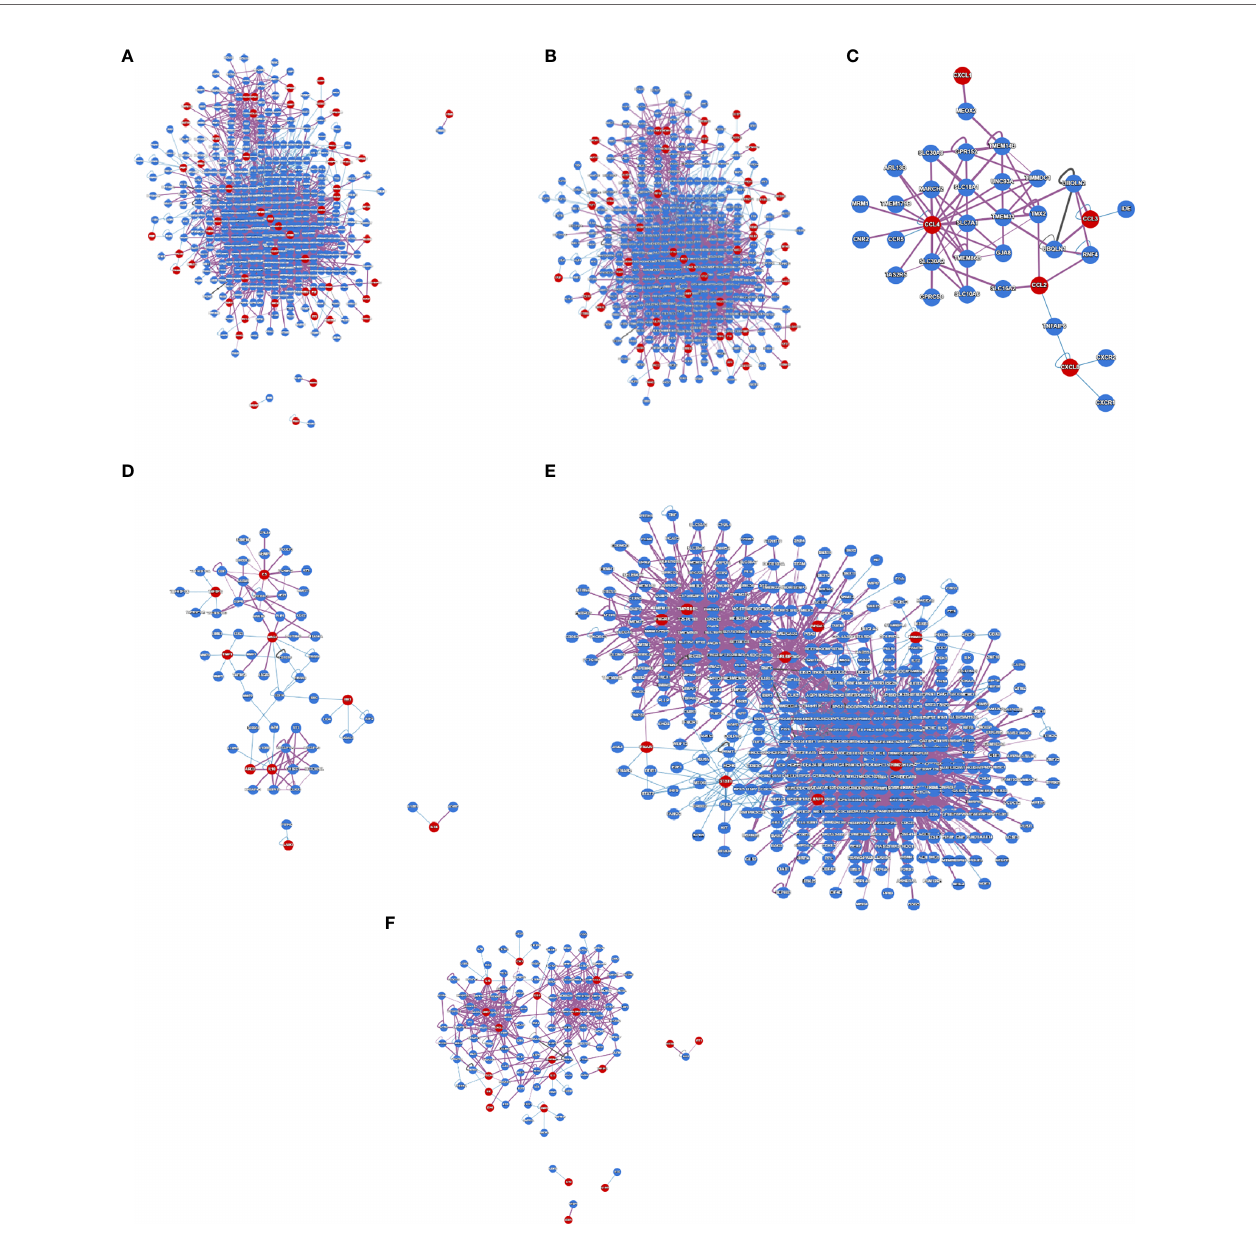
FIGURE 6 | The protein interactome map constructed using protein-coding DEGs from our study and other studies. (A) The protein interactome map with protein-coding genes from the 250 DEGs in our research. (B) The protein interactome map of the central cluster from our study was identi fi ed from (A) . (C) The protein interactome map from Xiong et al. study where the samples were the bronchoalveolar lavage fl uid. (D) The protein interactome map with the top-ranked genes of the Xiong et al. study from the PBMC samples. (E) The protein interactome map with data from the Ziegler et al. study where the samples were collected from the lung lobe, nasal polyps, ethmoid sinus surgical tissue, and ileum. (F) The protein interactome map with the top-ranked genes of the Jain et al. study that used nasopharyngeal swab